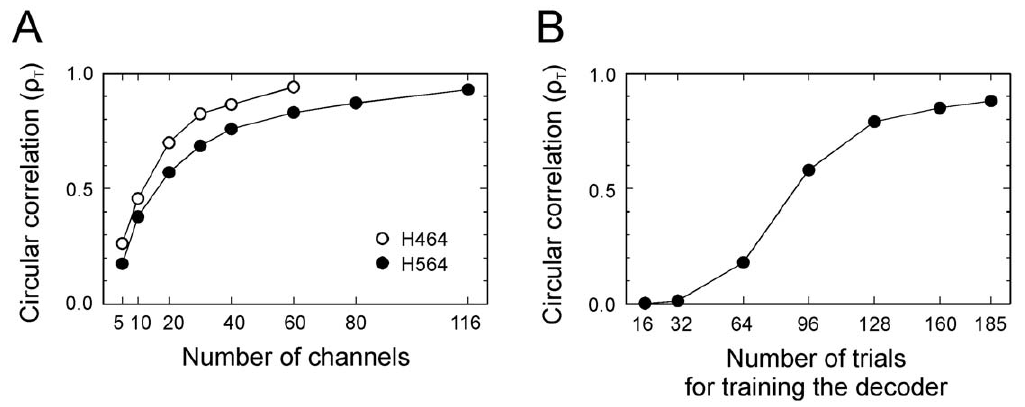
Figure 6. Decoding accuracy varies with number of channels and trials. (A) Circular correlation between predicted and actual target direction computed as a function of number of channels used for decoding. (B) Circular correlation between predicted and actual target direction computed as a function of number of trials used for training the decoding algorithm (data of H564 in session 2).